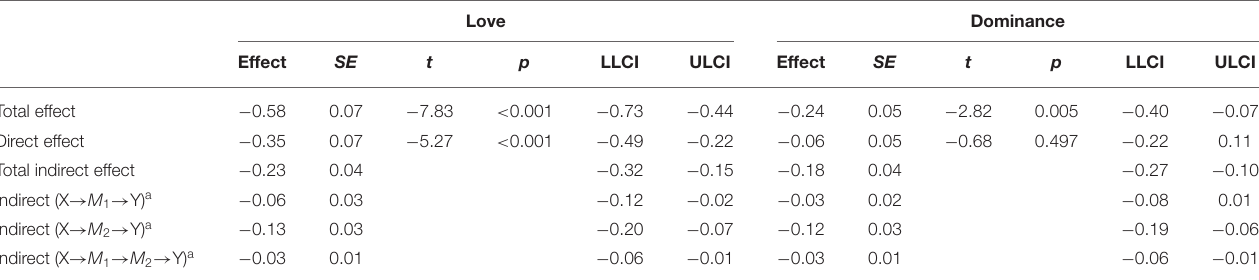
TABLE 6 | Total, direct and indirect effects of disagreeableness (X) on love (Y 1 ) and dominance (Y 2 ) through depression stigma (M 1 ) and empathic concern (M 2 ) in Study 2. Love Dominance Effect SE t p LLCI ULCI Effect SE t p LLCI